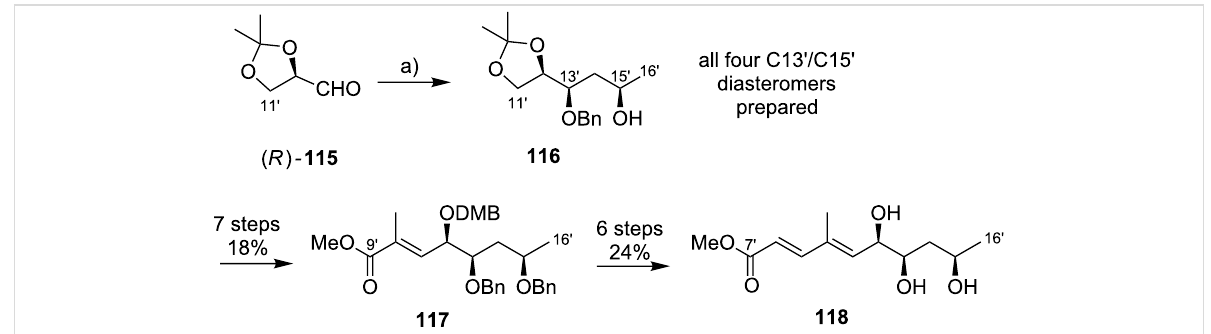
Scheme 14: Kishi’s synthesis of model compounds for elucidating the stereochemistry of the C7’–C16’ fragment of the mycolactone A/B pentaenoate side chain. Reagents and conditions: a) (i) ( R , R )- and ( S , S )-diisopropyl tartrate-modified allylboronate, 4 Å molecular sieves, toluene, − 78 °C, then NaBH 4 , EtOH, − 78 °C; (ii) NaH, BnBr, DMF, 0 °C to rt, 88%; (iii) OsO 4 , NMO, DABCO, THF/H 2 O 10:1, rt; (iv) Pb(OAc) 4 , benzene, rt; (v) MeLi, CuI, − 20 °C, 83% (3 steps), 1:1 mixture of